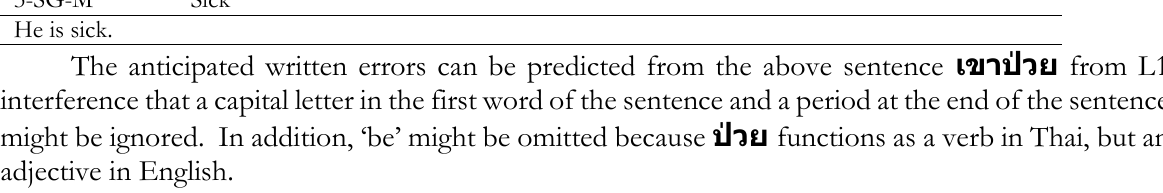
TABLE 2. Language Interference 1